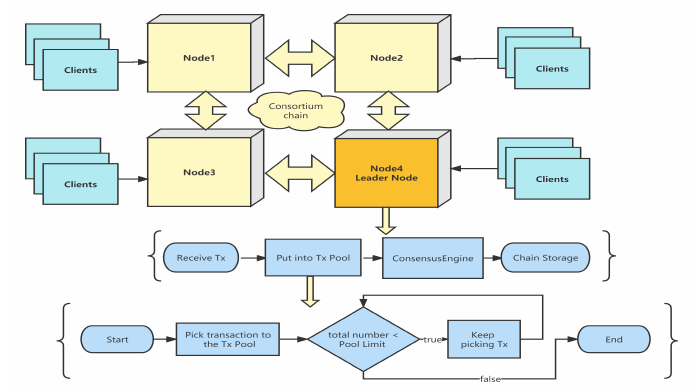
Figure 1. The PBFT consensus protocol.